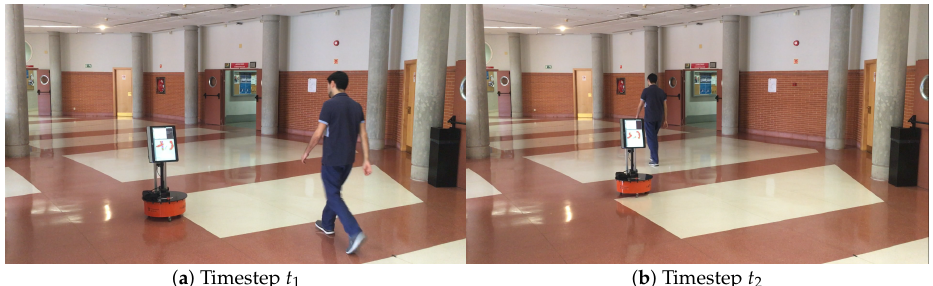
Figure 32. Scenario 3—Images sequence.